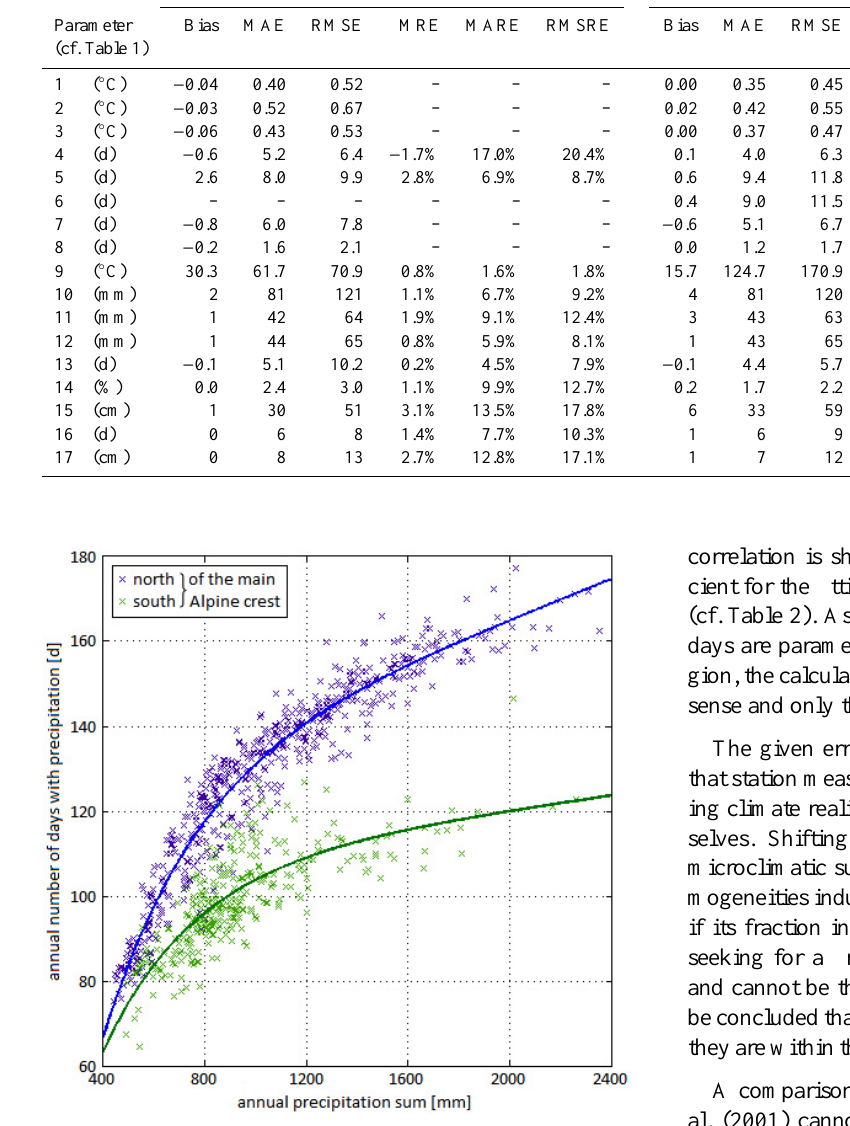
Figure 5. Exponential fitting of annual number of days with pre- cipitation to annual precipitation sum over two subsets of Austrian station data, i.e. stations north and south of the main Alpine